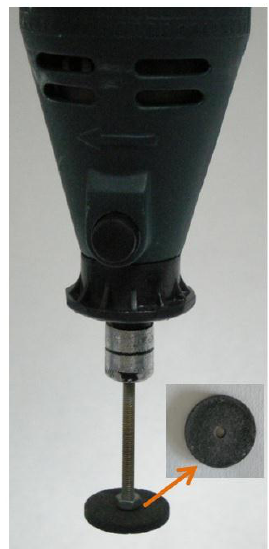
Figure 11. Borosilicate disk modified with carbon nanohorns extraction device. Reproduced with permission of from [67], copyright Elsevier, 2014.